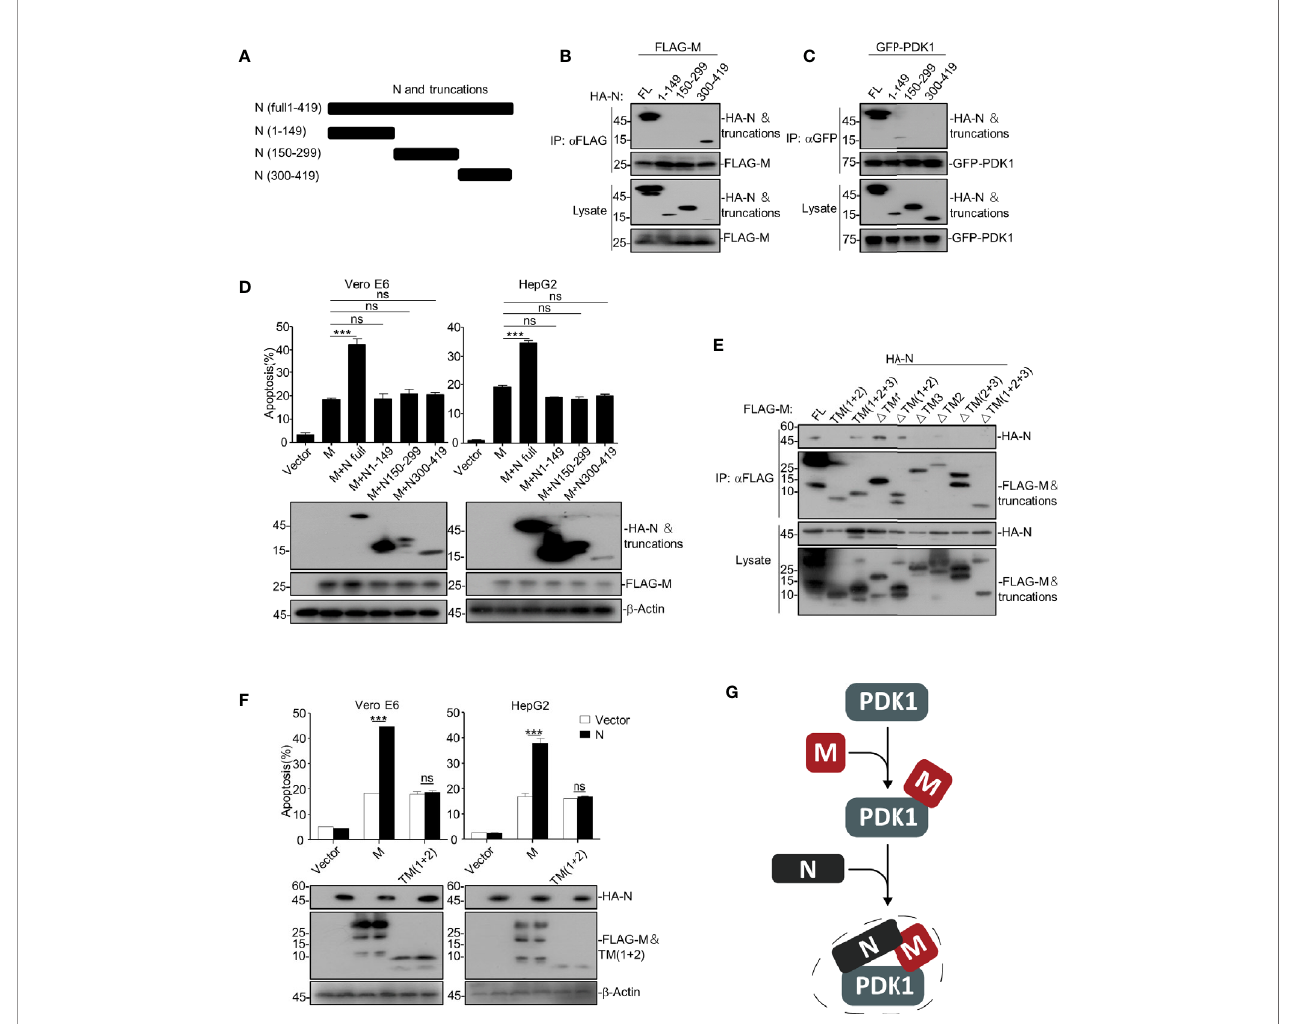
FIGURE 4 | SARS-CoV-2 N enhances M-induced apoptosis via interacting with both M and PDK1. (A) Schematic representation of SARS-CoV-2 N and its truncations. (B, C) HEK293T cells transfected with HA-SARS-CoV-2 N and its truncations together with FLAG-SARS-CoV-2 M and GFP-PDK1, respectively. After 24 h, cells were collected for co-immunoprecipitation (with anti-FLAG or anti-GFP) and Western blotting (with anti-GFP, anti-HA, or anti-FLAG). (D) Vero E6 and HepG2 cells were transfected with FLAG-SARS-CoV-2 M together with HA-SARS-CoV-2 N and its truncations, respectively. After 24 h, cells were collected for Western blotting (with anti-FLAG, anti-HA, or anti- b -Actin) or stained with Annexin V-FITC/PI for fl ow cytometry analysis, and the percentage of apoptotic cells were measured. (E) HEK293T cells transfected with FLAG-SARS-CoV-2 M andits truncations together with HA-N. After 24 h, cells were collected for coimmunoprecipitation (with anti-FLAG) andWestern blotting(with anti-FLAG or anti-HA). (F) VeroE6 and HepG2 cellswere transfected with FLAG-SARS-CoV-2 M andFLAG-SARS-CoV-2 M TM(1 + 2) together with HA-SARS-CoV-2 N. After 24 h,cells were collected for Western blotting (with anti-FLAG,anti-HA, or anti- b -Actin) orstained with Annexin V-FITC/PI for fl ow cytometry analysis, and the percentage of apoptotic cells were measured. (G) A model for SARS-CoV-2 N enhancingthe interaction of M and PDK1. *** P < 0.001 by two-tailed Student ’ s t -test. ns, nonsigni fi